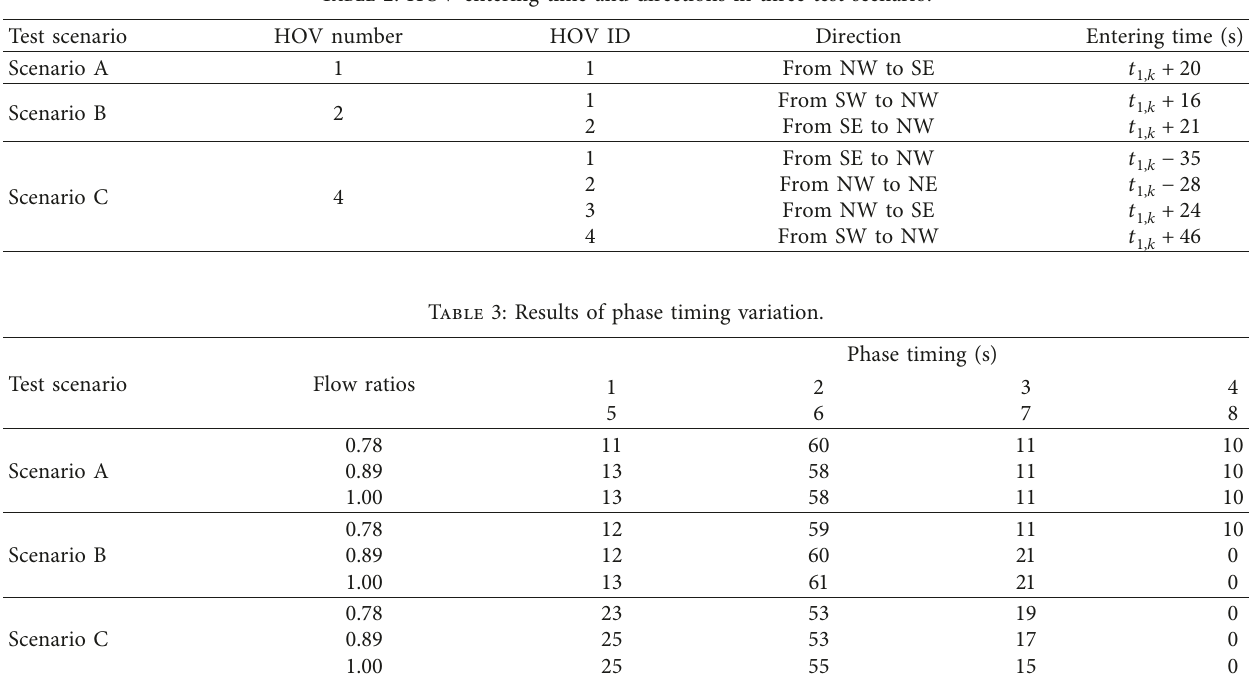
Table 2: HOV entering time and directions in three test scenario.